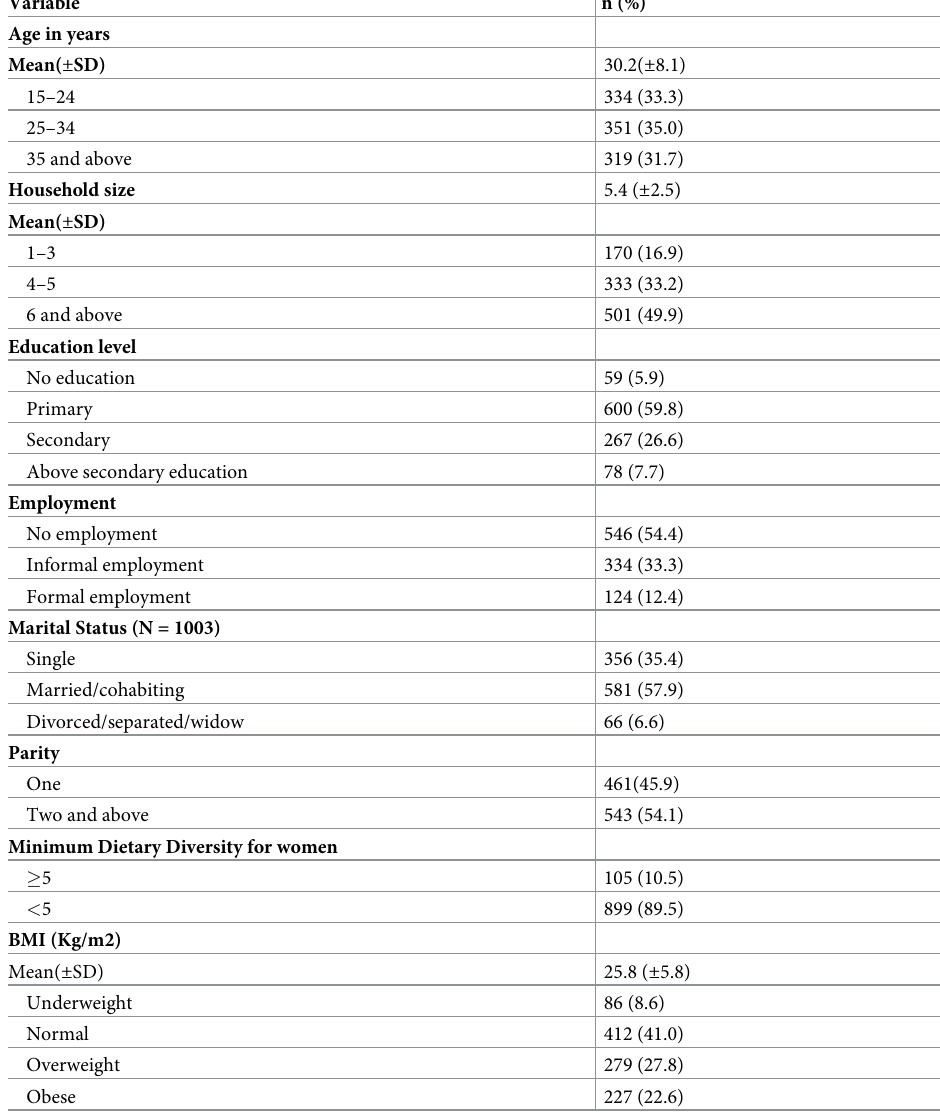
Table 1. Background characteristics of women of reproductive age in Dar es Salaam, Tanzania (N =